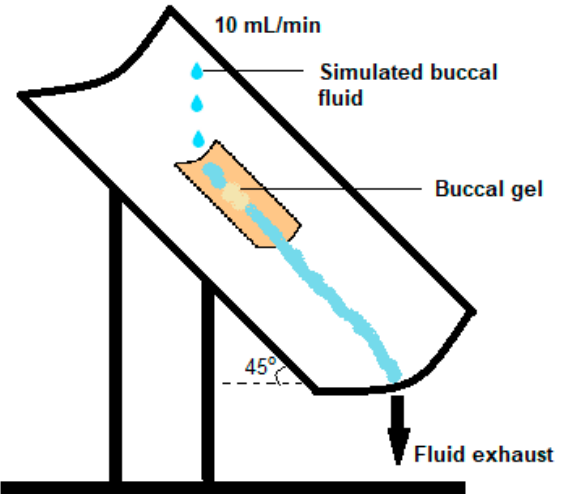
Figure 11. Simulation for estimation of ex vivo mucoadhesive flow time of buccal SGs [27].